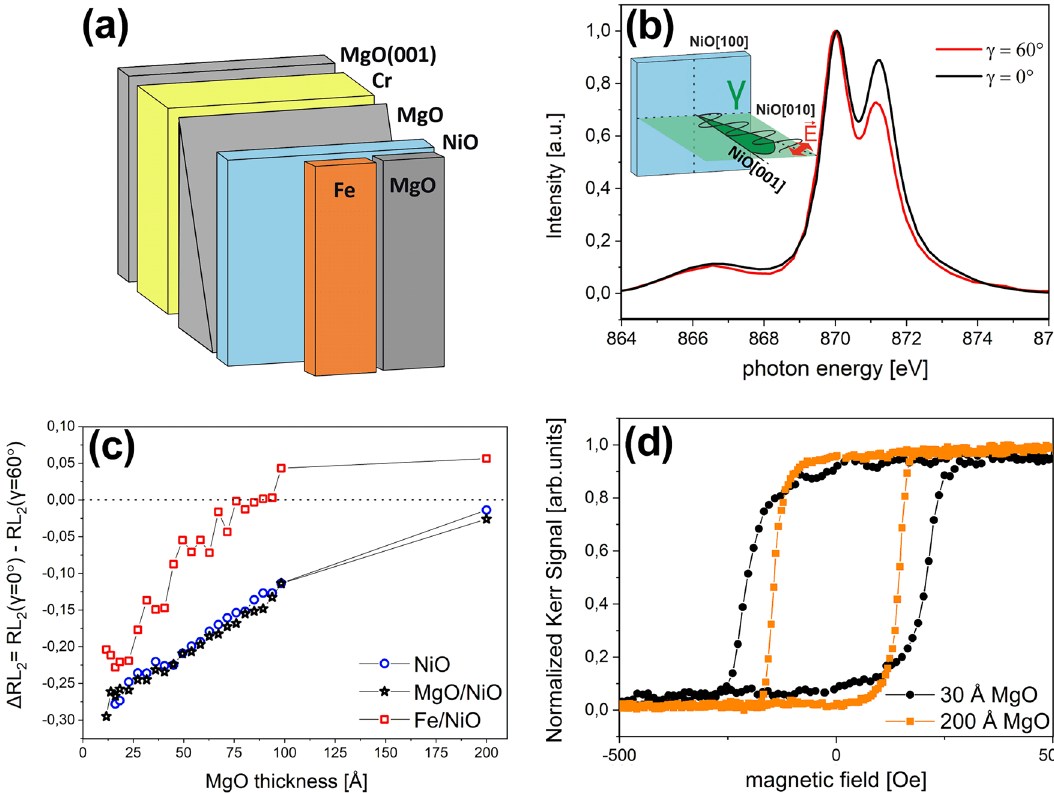
Figure 1. ( a ) Schematic sketch of the sample. ( b ) Exemplary Ni 2+ L 2 -edge XAS spectra at γ = 0° (black line) and γ = 60° (red line) obtained at RT for NiO/MgO(18.3 Å)/Cr/MgO(001). The scheme in the inset shows the geometry of the XMLD experiment. ( c ) ∆RL 2 ratio dependence on the MgO thickness in NiO/MgO( d MgO )/ Cr (blue dots), MgO/NiO/MgO( d MgO )/Cr (black stars) and Fe/NiO/MgO( d MgO )/Cr (red squares). ( d ) LMOKE magnetic hysteresis loops acquired with external magnetic field along the Fe[100] direction at RT for Fe/NiO/ MgO(30 Å)/Cr (black dots) and Fe/NiO/MgO(200 Å)/Cr (orange